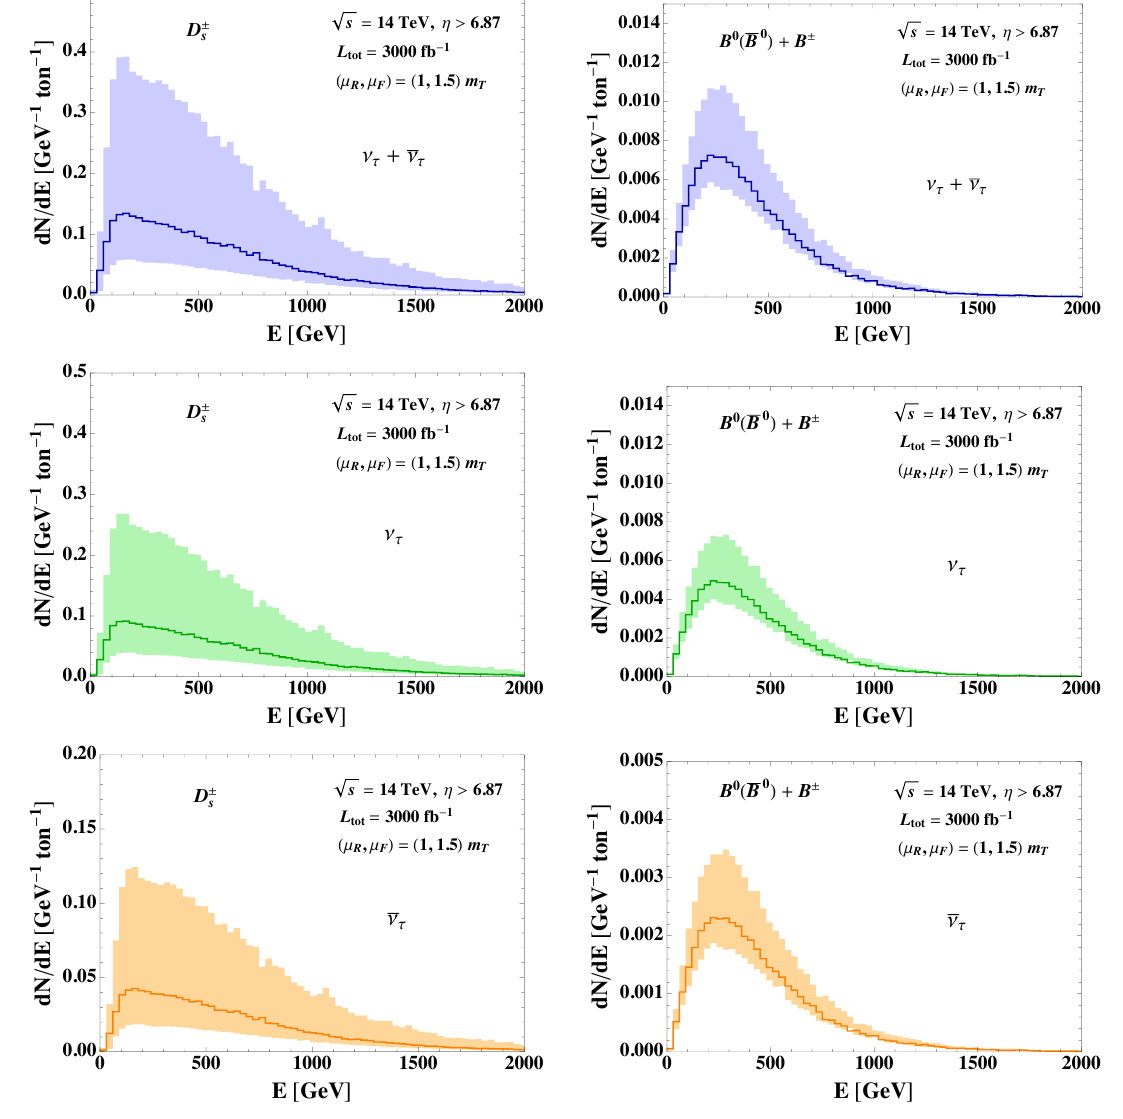
Figure 6 . Uncertainty range due to the QCD scale variation in the tau neutrino and antineutrino number of charged-current events per GeV per ton as a function of the incident neutrino energy p for neutrino pseudorapidity (cid:17) > 6 : 87 in pp collisions with s = 14 TeV and integrated luminosity L = 3000 fb (cid:0) 1 . The central predictions are obtained using as input ( (cid:22) R ; (cid:22) F ) = (1 ; 1 : 5) m T and h k T i = 0 : 7 GeV. The upper and lower limits arise from the QCD 7-point scale variation range in (cid:12)gure 1. NLO QCD corrections are accounted for in the DIS pQCD cross section.